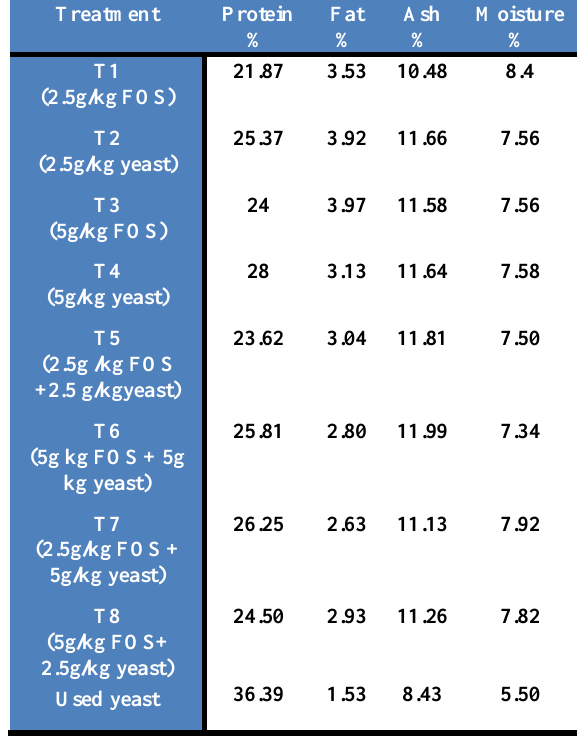
combination (synbiotic), the chemical composition of the different diets are shown in (Table, 1). Table, 1: The chemical composition of experimental diet.